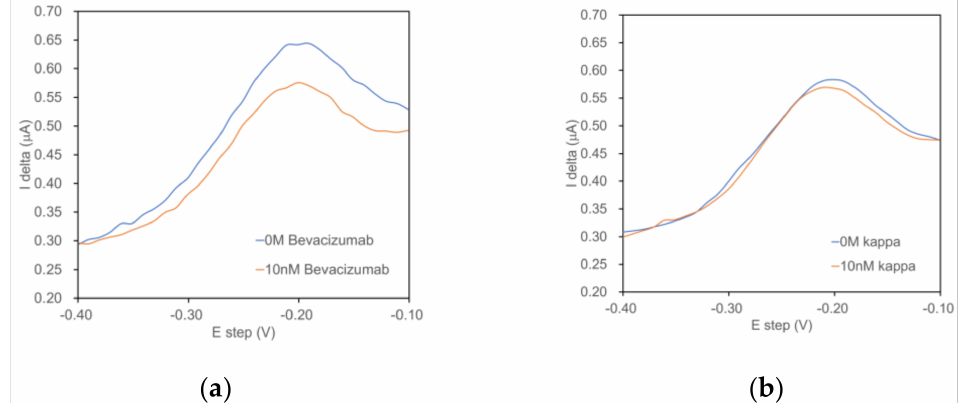
Figure 3. Square − wave voltammograms recorded with the addition of ( a ) 10 nM bevacizumab and ( b ) 10 nM human IgG kappa chain.